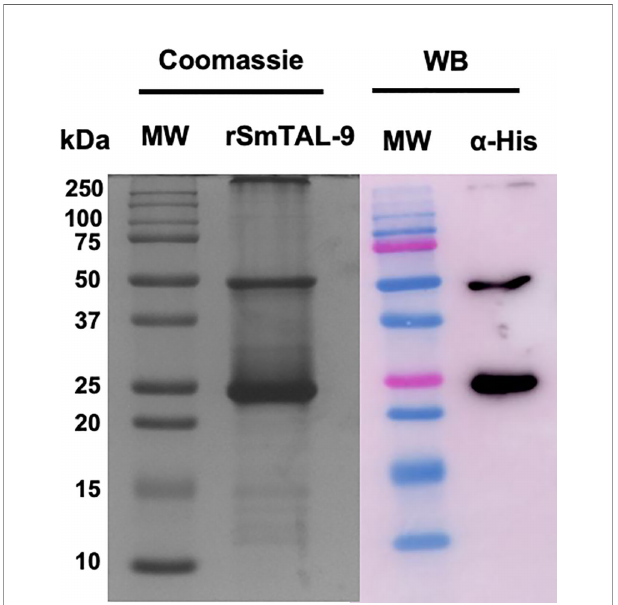
FIGURE 4 | Electrophoretic and western blot analysis of the puri fi ed recombinant SmTAL – 9. Puri fi ed rSmTAL – 9 was detected using 15% SDS – PAGE stained with Comassie blue. Precision plus Protein ™ Dual color standard from BioRad was used as the molecular weight standard (MW). Recognition of the 6XHis – tag from the recombinant protein was analyzed via western blotting using an anti – His ( a – His)